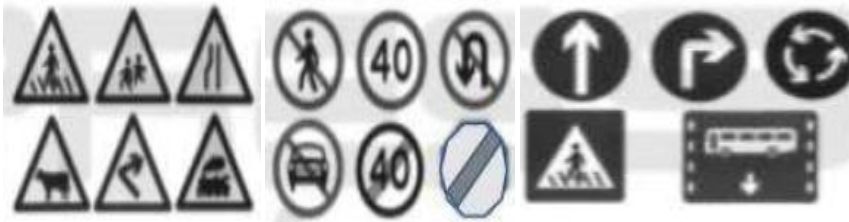
Fig. 1. Warning, prohibition and mandatory